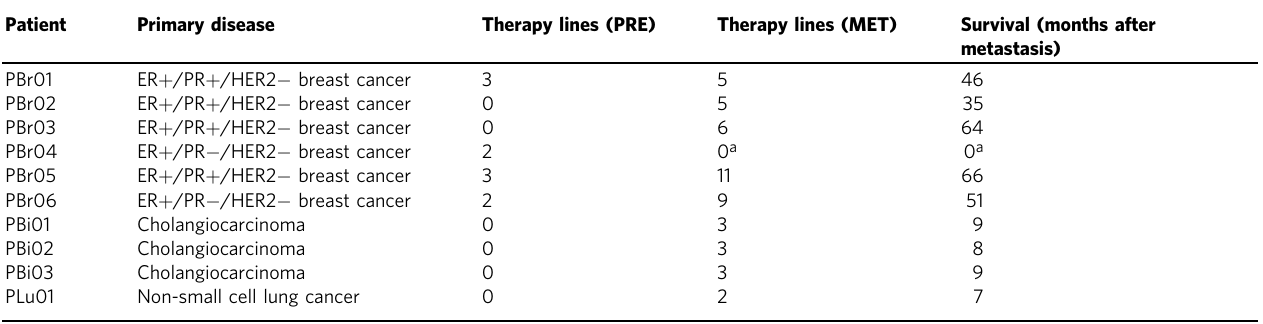
Table 1 Clinical characteristics of patients in the study. Patient Primary disease Therapy lines (PRE) Therapy lines